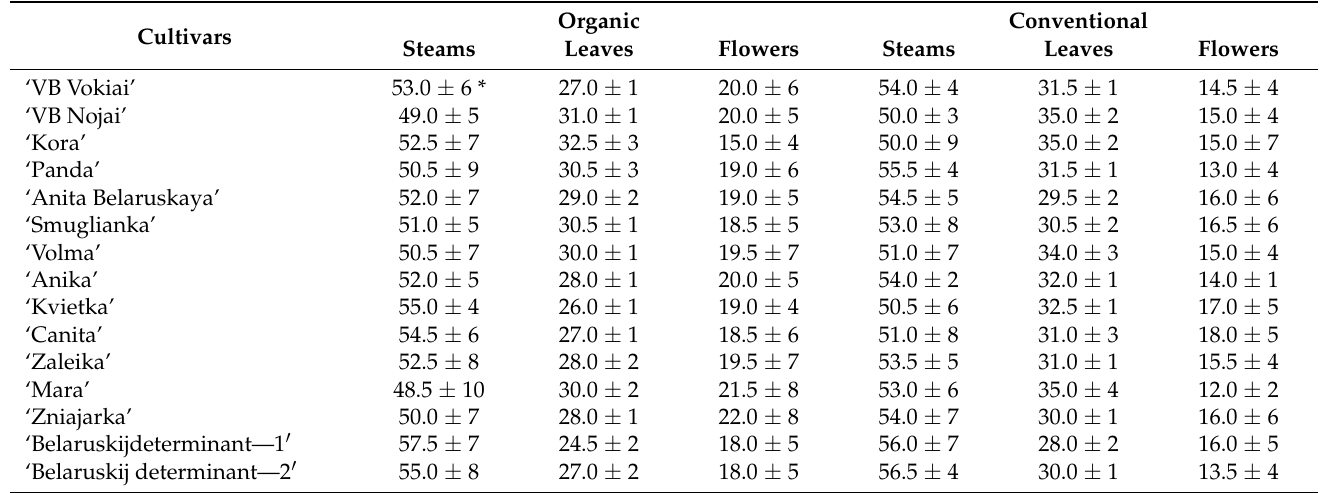
Table 3. Relative content (%) of morphostructural elements in plants of different buckwheat cultivars in organic and conventional farming systems.